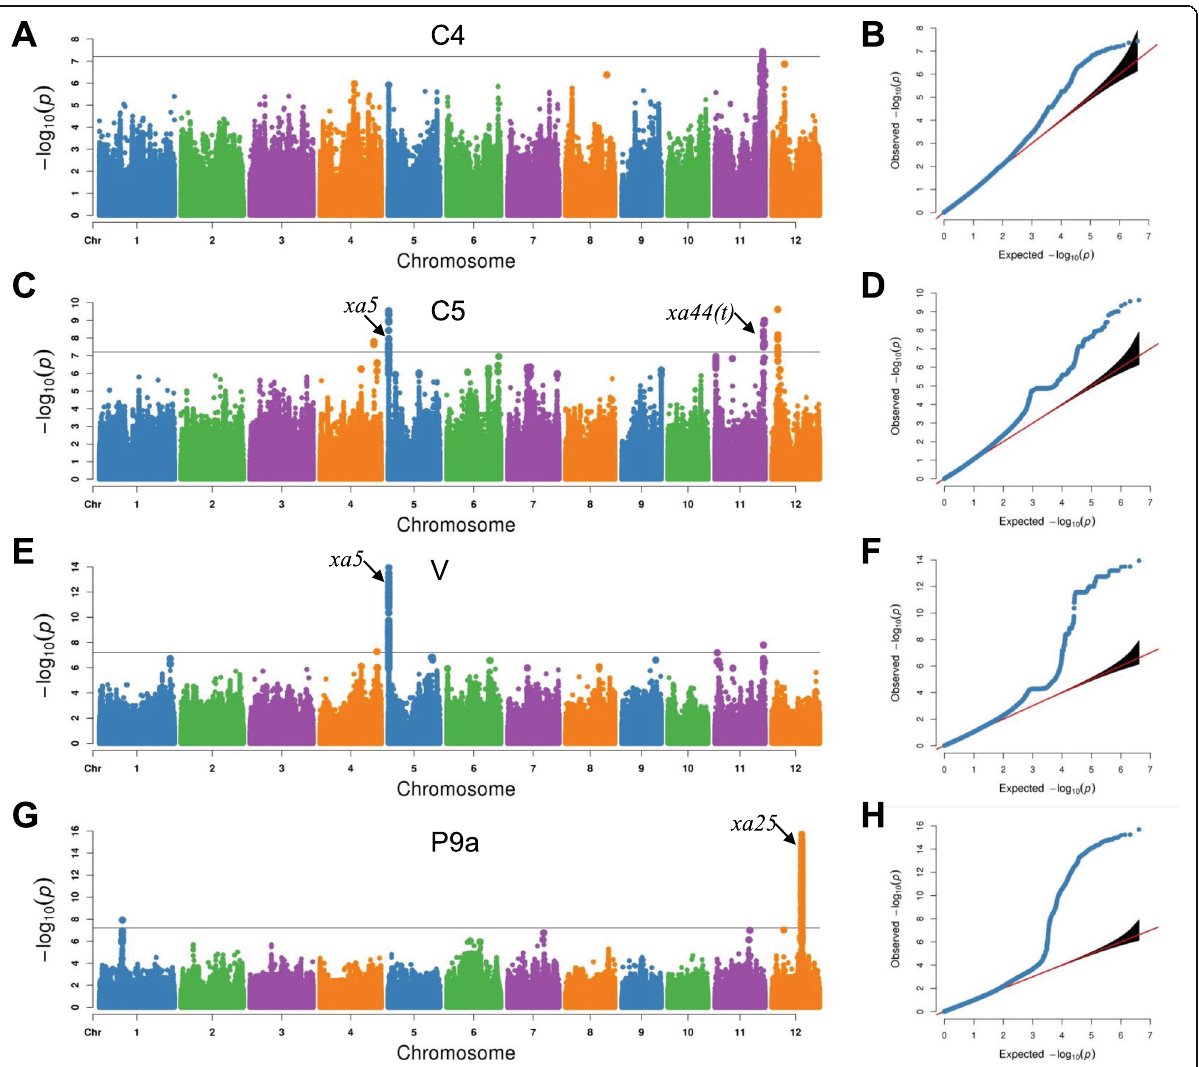
Fig. 3 Genome-wide association study of rice resistance to four Xoo strains. a , c , e , g Manhattan plots of GWAS results for strains C4, C5, V, and P9a, respectively. b , d , f , h Quantile-quantile plots of expected and observed − log 10 ( P -value) for strains C4, C5, V, and P9a, respectively. Horizontal black line indicates the significant P -value threshold of 6.31E − 8. The arrows indicate the reported bacterial blight resistance